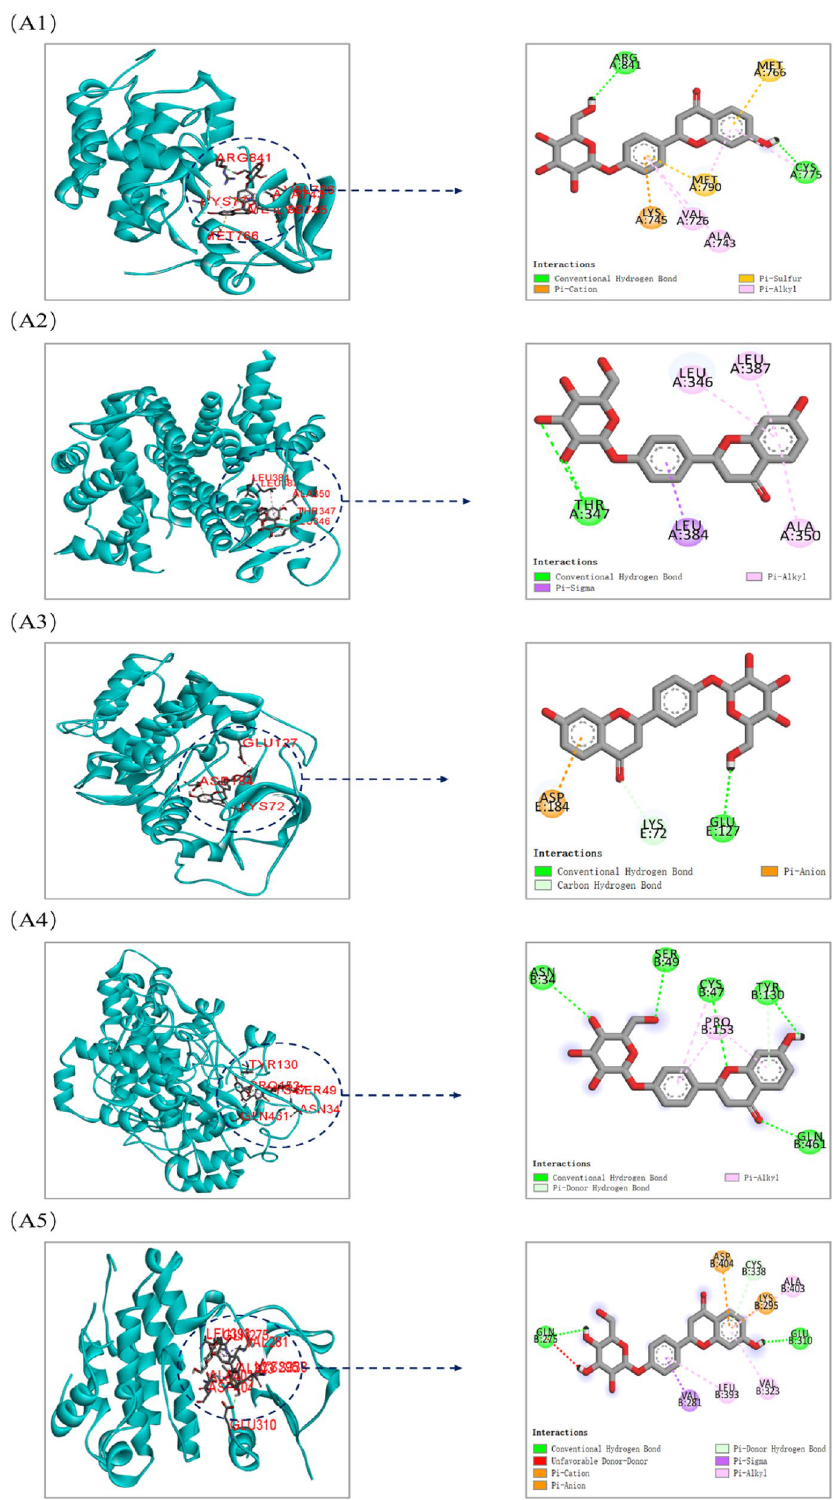
Figure 11. Molecular docking models of liquiritin and hesperetin binding to the five core targets. ( A1 – A5 ) the binding interaction between liquiritin and EGFR, ESR1, AKT1, PTGS2, SRC, respectively. ( B1 – B5 ) the binding interaction between hesperetin and EGFR, ESR1, AKT1, PTGS2, SRC, respectively (this figure was drawn by the Discovery Studio Client software (version